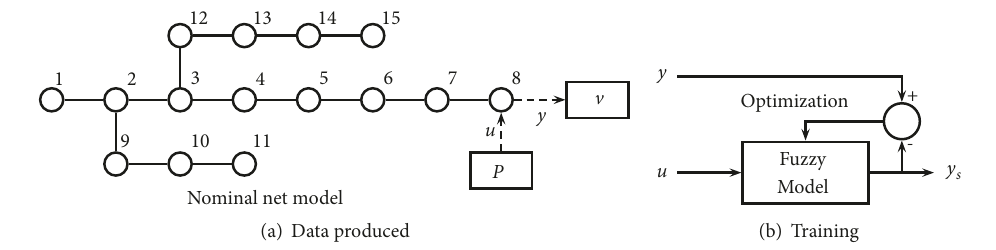
Figure 3: Plant identification using the grid nominal model.